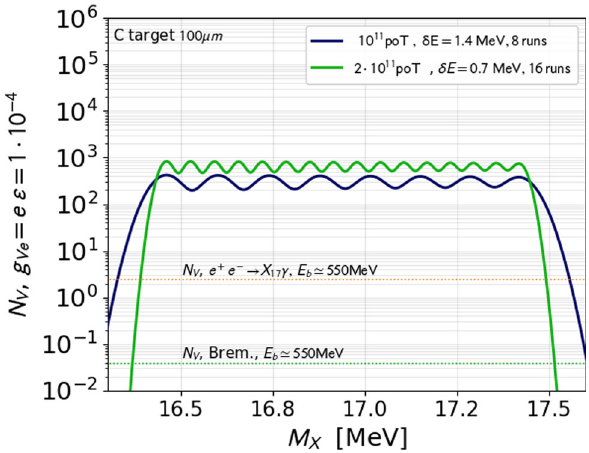
Fig. 36 Number of produced X 17 boson in a PADME-like experimen- tal setup, assuming either a beam spread δ E of 0 . 7 MeV with an inte- grated 2 · 10 11 poT (green curve) or δ E = 1 . 4 MeV with 10 11 poT (blue curve). The X 17 coupling with electron is fixed at g e = 10 −